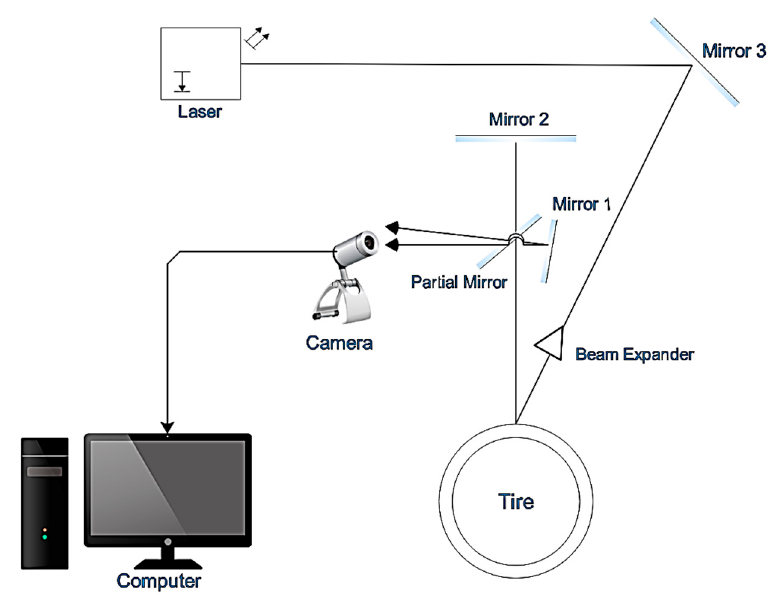
Figure 1. Digital shearography set-up for capturing tire shearography images.